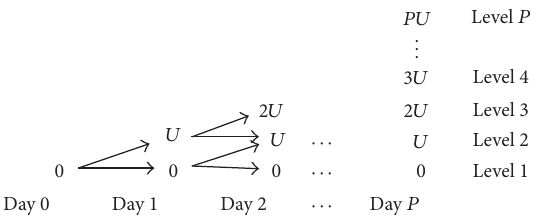
Figure 2: Construction of a CHDD tree using a binomial